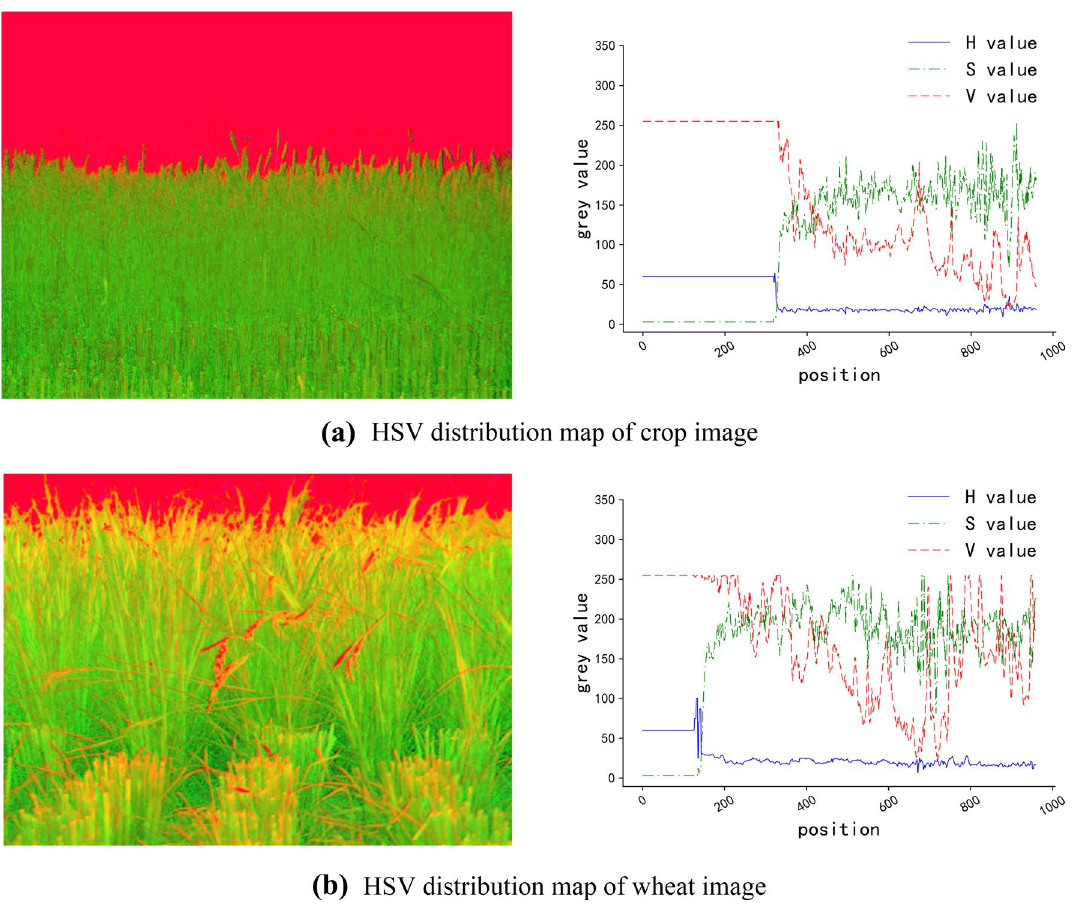
Fig. 3 HSV gray value distribution